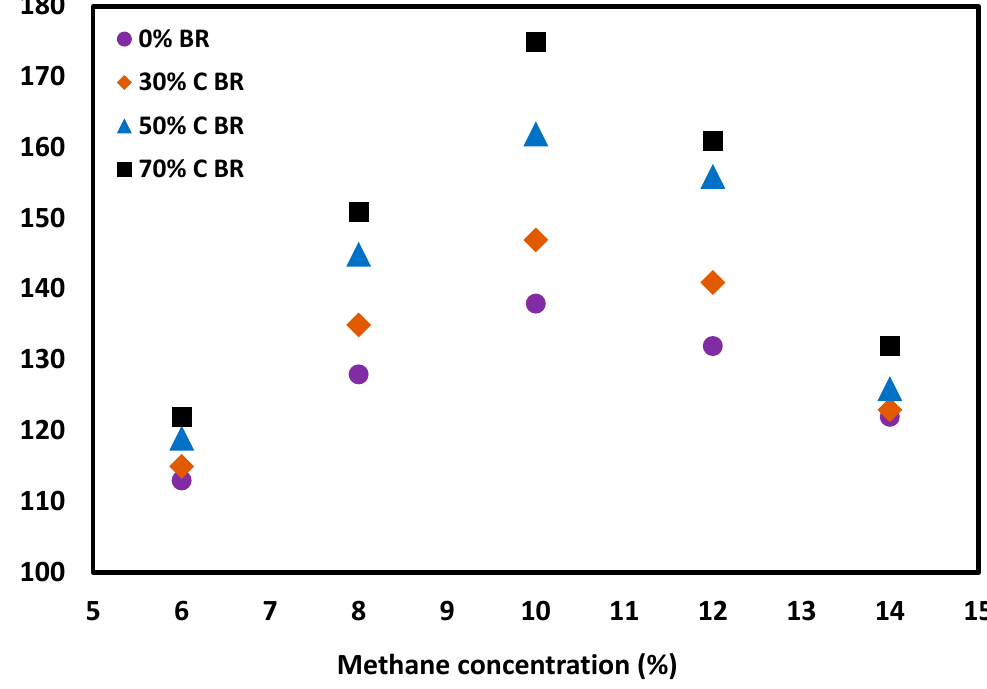
Figure 5. Maximum pressure for different methane–air concentrations in the straight tube and when the tube included 30%, 50% or 70% blockage ratio of orifice plate positioned at 2.4 m from the ignition source.